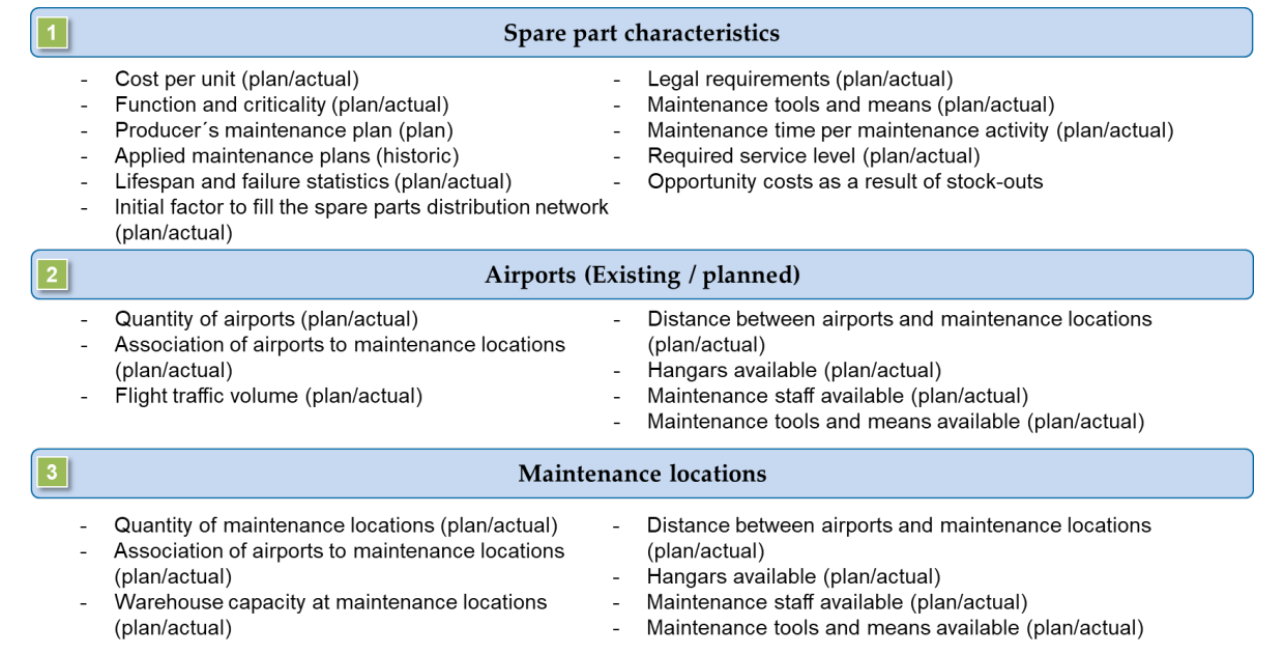
Figure 1. Elements and their characteristics (own elaboration).